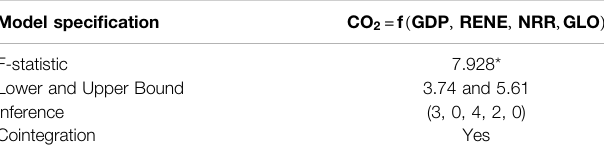
TABLE 4 | ARDL approach to cointegration.